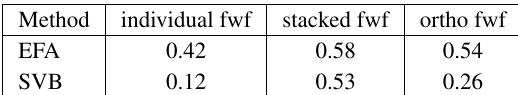
Table 1. Correlation